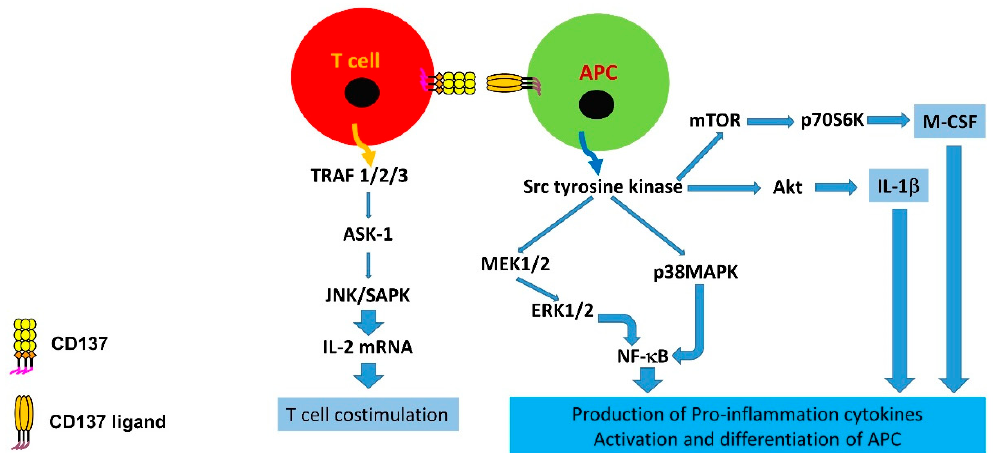
Figure 1. Signalling pathways mediating signal transduction of CD137 and CD137L in human leukocytes. APC: Antigen-presenting cell.